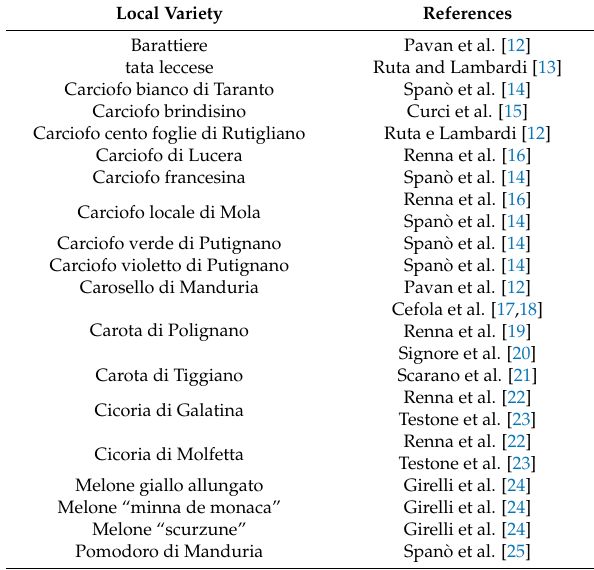
Table 2. Literature published targeting the different local varieties studied during project